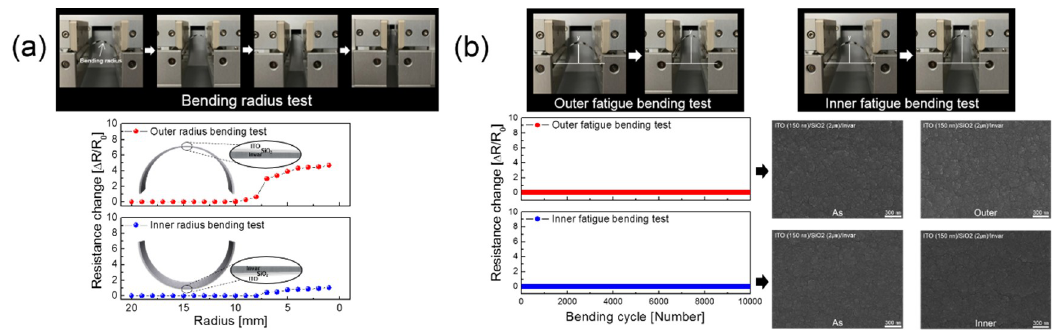
Figure 5. ( a ) Upper panels show pictures of the outer bending test steps with decreasing bending radius. Results of the outer and inner bending test with decreasing bending radius of 150 nm thick ITO films on SiO 2 /invar substrate. Insets show the schematics of curved sample experiencing tensile and compressive stress. ( b ) Results of the outer and inner dynamic bending fatigue tests at a fixed bending radius of 15 mm for the 150 nm thick ITO films on SiO 2 /invar substrate. The right side shows FESEM images of the ITO film before and after dynamic fatigue test after 10,000 cycles.